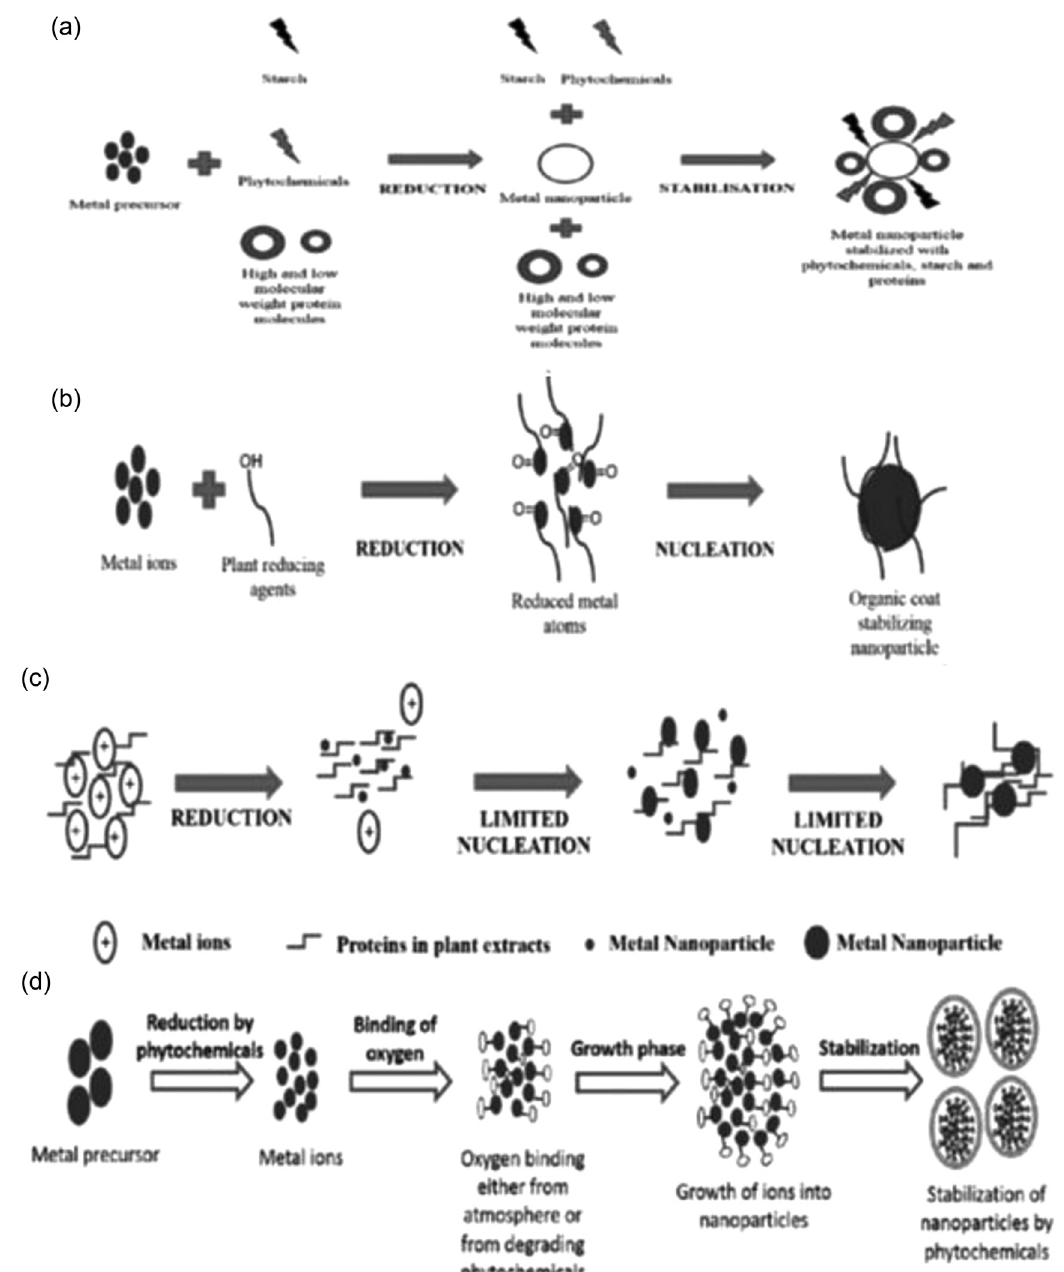
Figure 8: Metal and metal oxide nanoparticles formation mechanism by phytochemicals: Metal and metal oxide nanoparticle formation